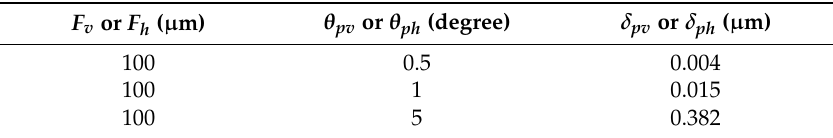
Table 2. Error analysis of the PSD setup.